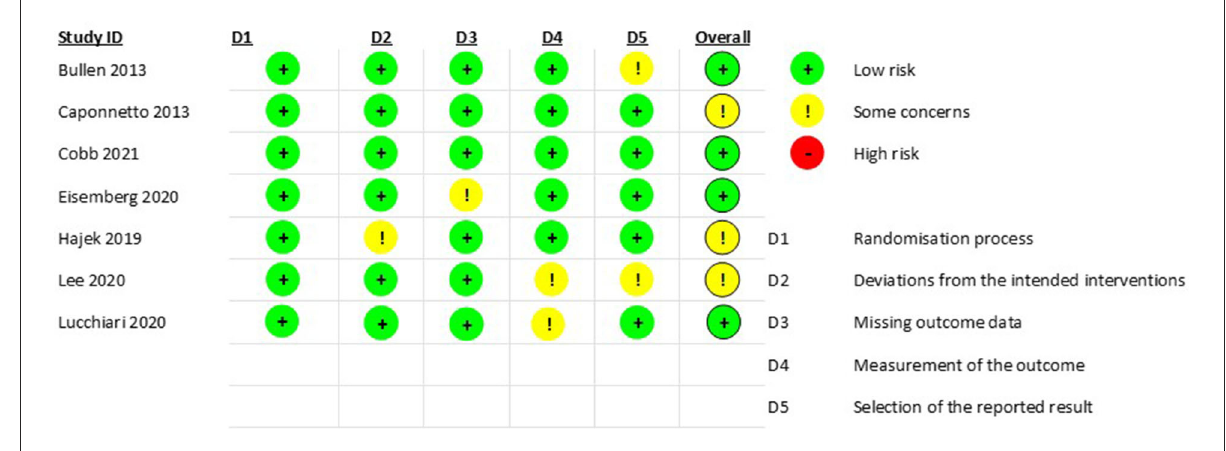
FIGURE2 Risk of bias of included